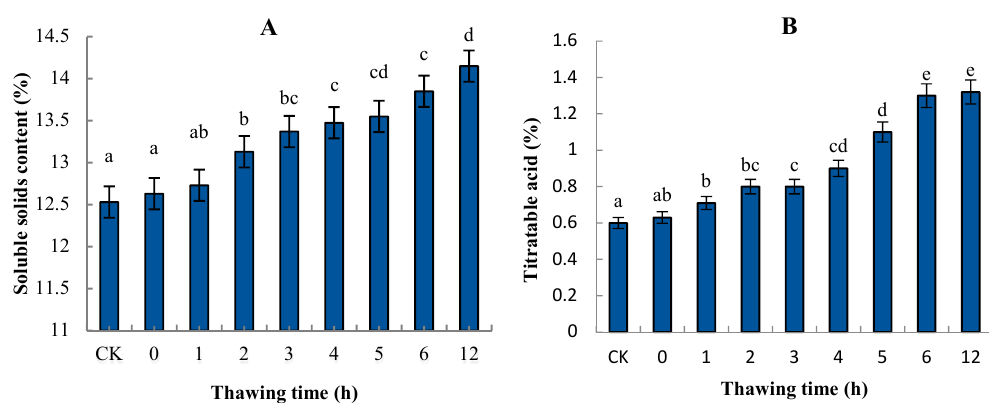
Figure 5. The change in soluble solids content (SSC) ( A ) and titratable acidity (TA) ( B ) content in “Ruaner” pear during the freezing–thawing stage. Different letters indicated significant differences between thawing time treated and control (Duncan’s multiple range test, p < 0.05).